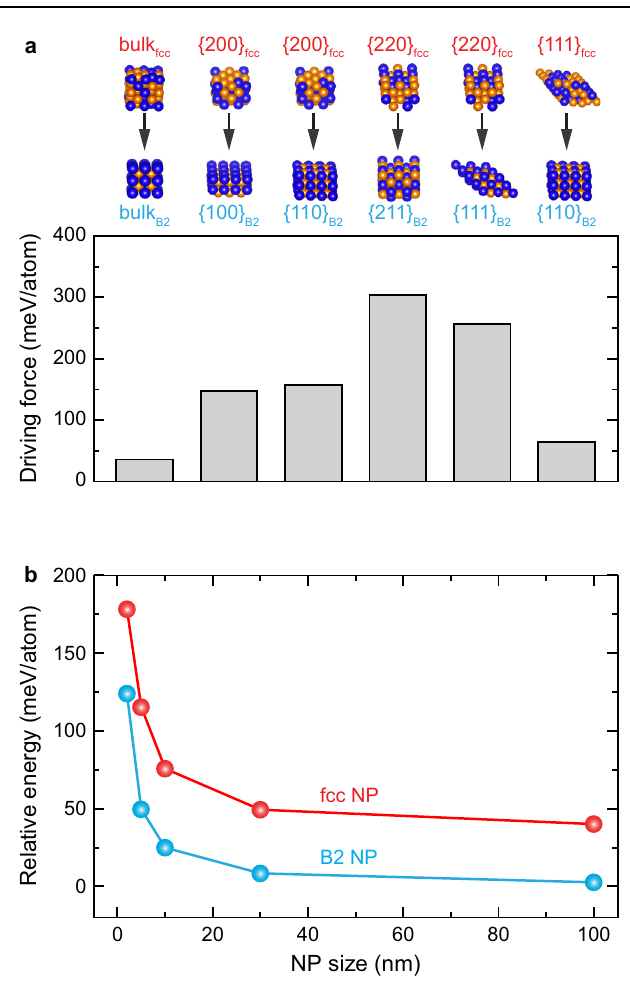
Fig. 4 | Driving force for fcc-to-B2 phase transition. a Driving forces or relative energies for the fcc-to-B2 phase transition in bulk crystal and for different surface planes. The relative energies were obtained using DFT calculations for the bulk supercells and surface slab modelsoffcc and B2 phases shown above the the plot. b Calculatedrelativeenergiesoffccand B2NPs(withrespecttothebulkB2phase) as a function of NP